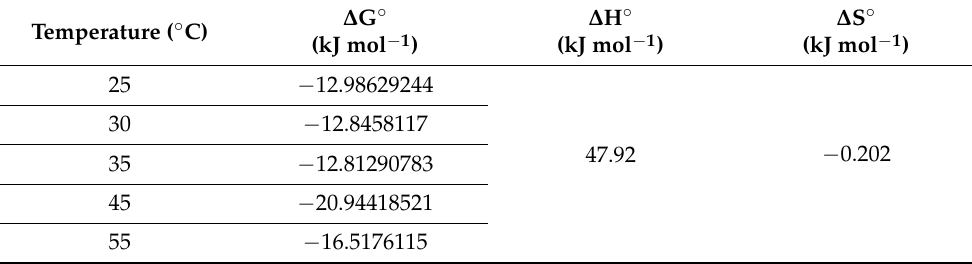
Table 6. Thermodynamic factors of the sorption of IV2R onto